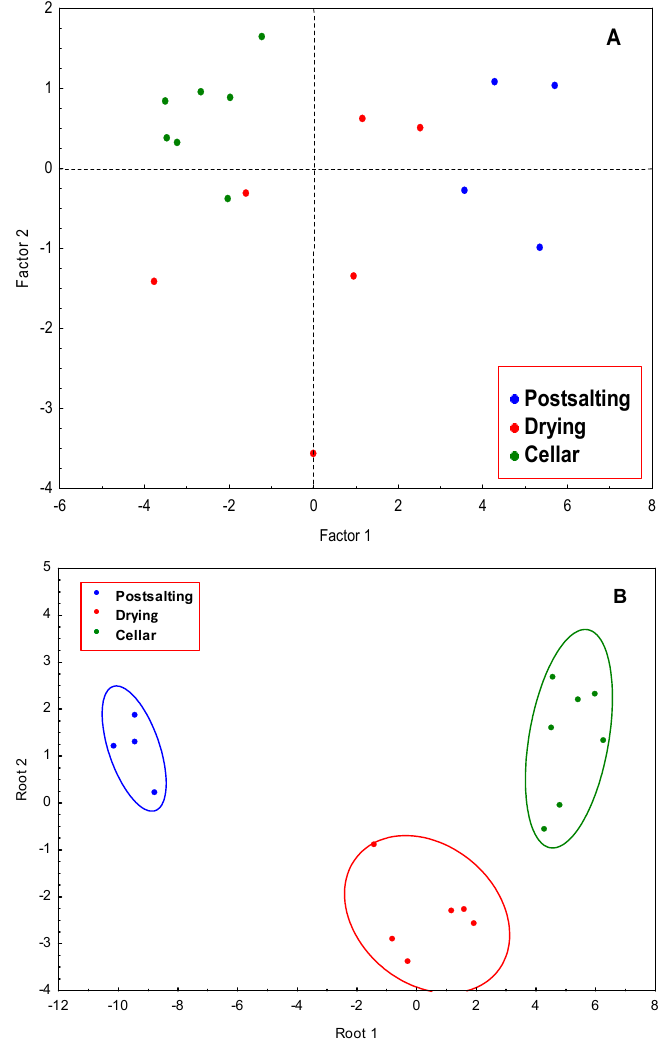
Figure 5. ( A ) Scores plot of Iberian dry-cured ham samples for the first PCs; blue, red, and green dots correspond to postsalting, drying, and cellar samples, respectively; ( B ) Scatter plot of the Iberian dry-cured ham samples in the plane of the two first DFs (discriminant functions).